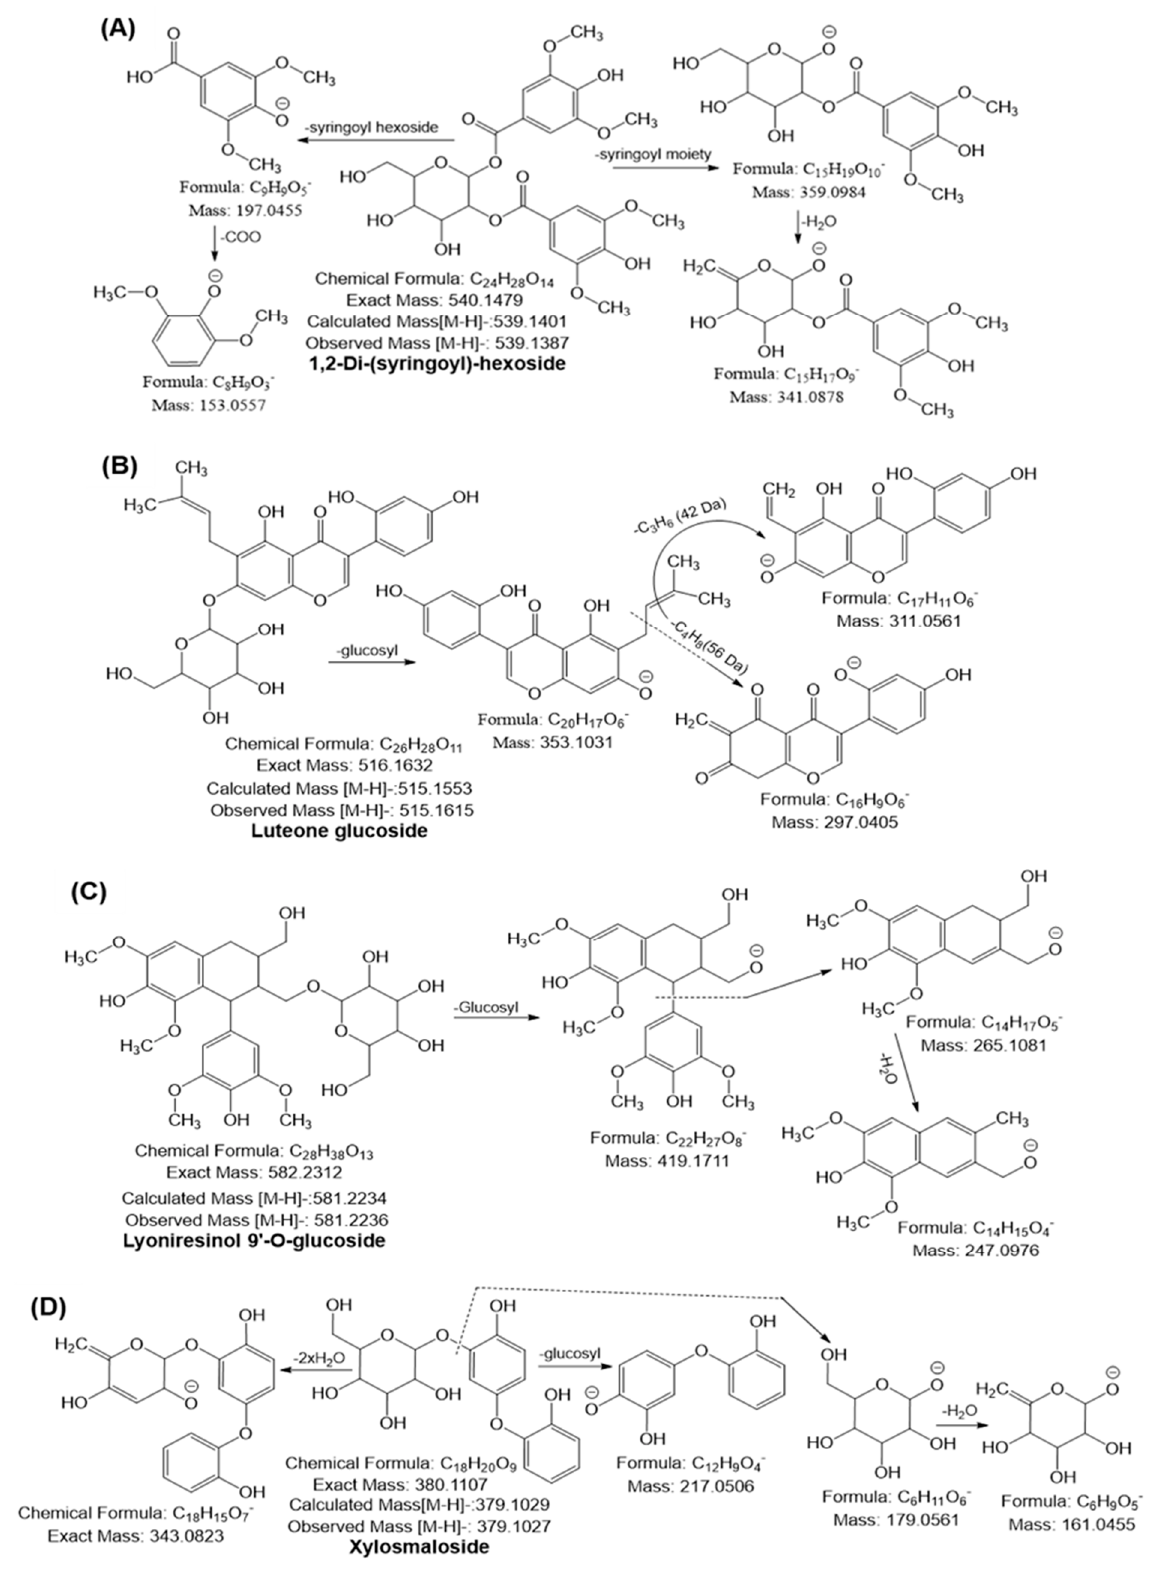
Figure 4. Tentative mass fragmentation behavior of 1,2–Di-(syringoyl)–hexoside ( A ), luteone glucoside ( B ), lyoniresinol 9– O –glucoside ( C ) and xylosmaloside ( D ).